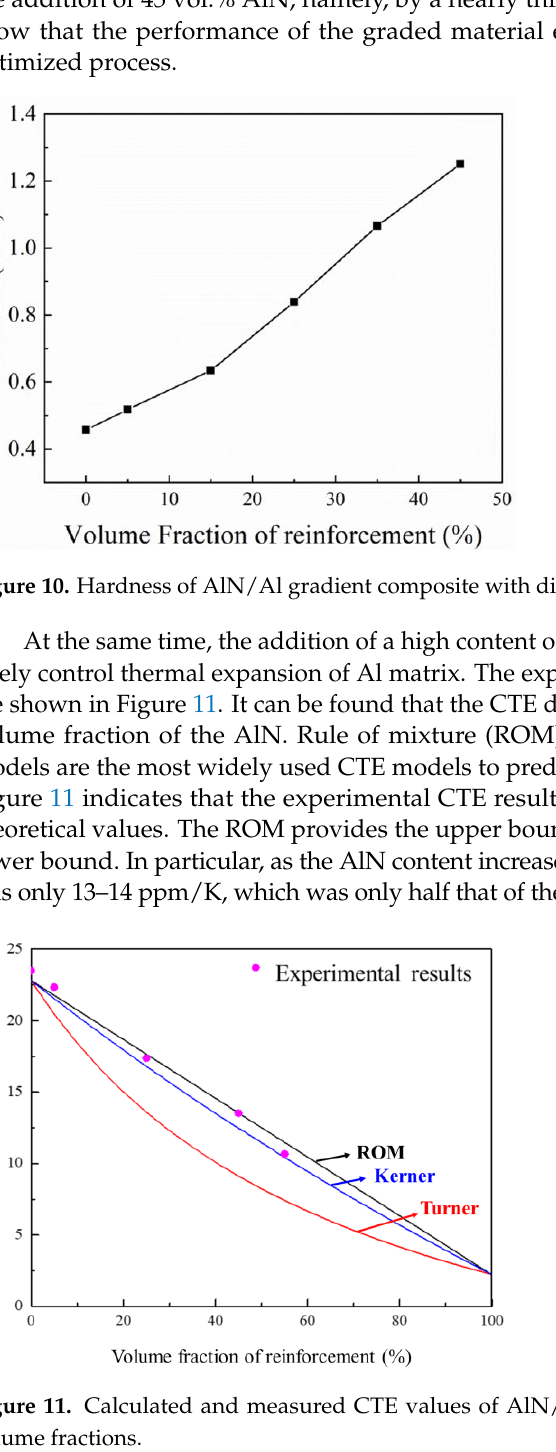
Figure 11. Calculated and measured CTE values of AlN/Al gradient composites with different vol- volume ume fractions.